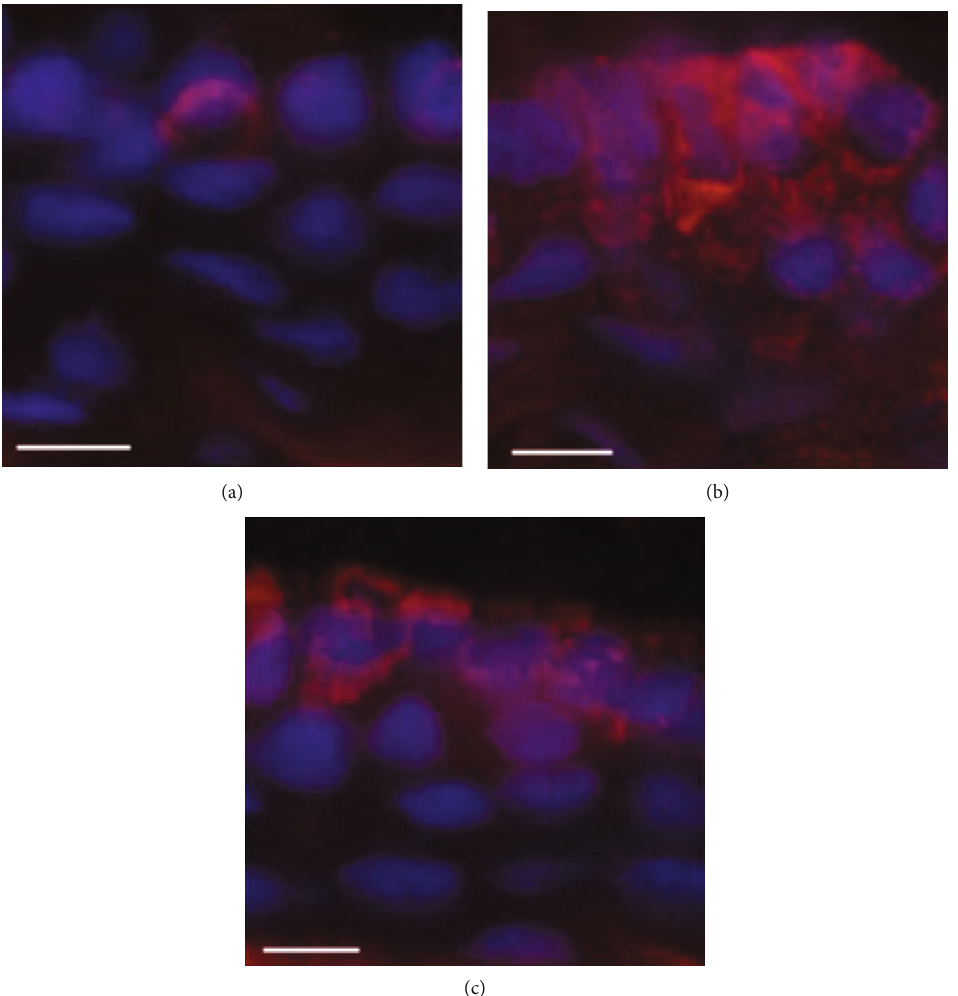
Figure 7: The result of immuno fl uorescence of CSF-1 in ICB. In the NC group, the positive expression of CSF-1 was few (a). In the EIU group, the positive expression of CSF-1 was widespread (b). In the ET group, the positive expression of CSF-1 was signi fi cantly reduced compared to the EIU group (c). Scale bars: 50 μ